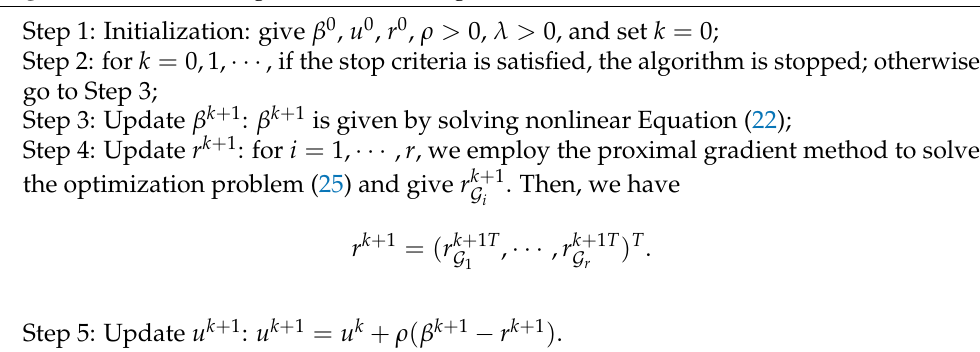
Algorithm 1 ADMM algorithm for solving